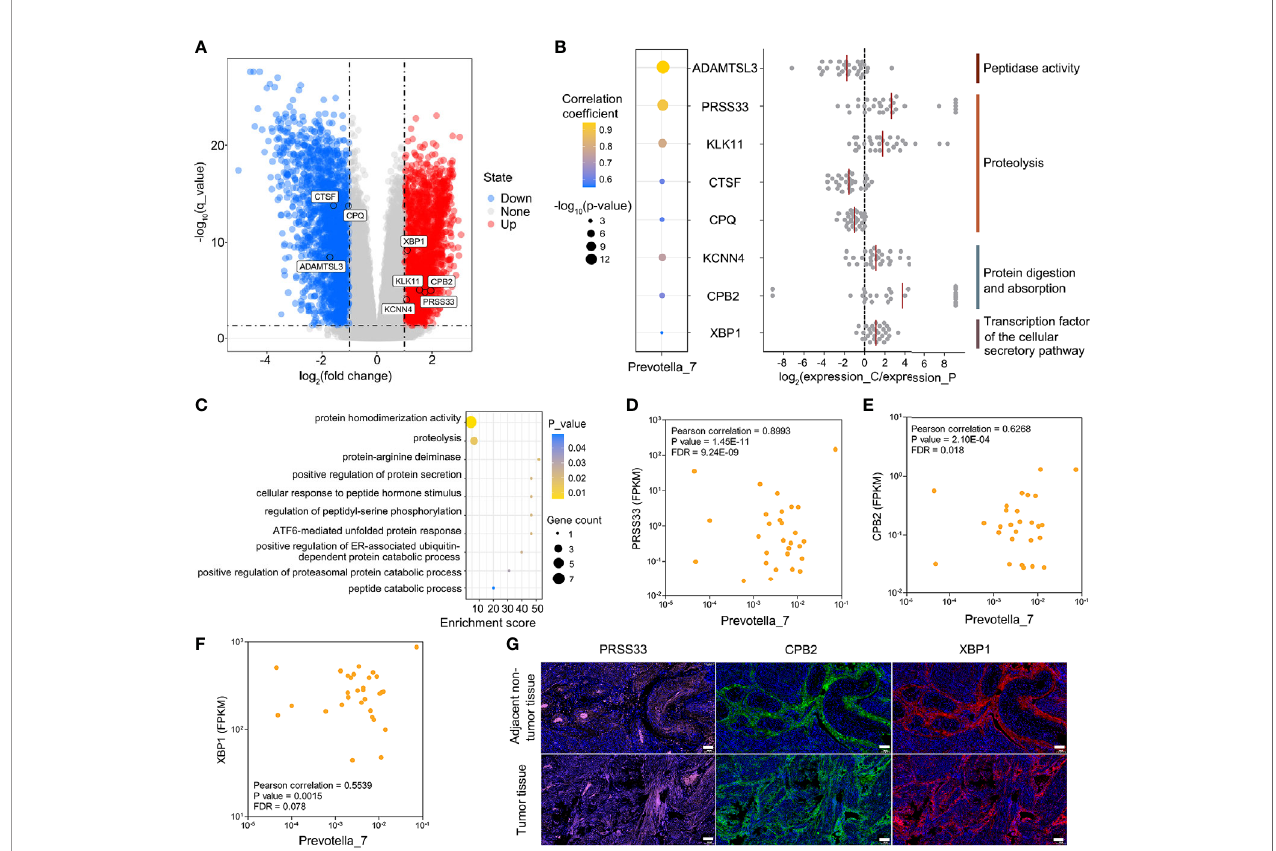
FIGURE 4 | Associations between host endometrial gene expression and Prevotella in patients with EC. (A) Differential expression of Prevotella -associated genes from 30 paired tumor and adjacent nontumor endometrial tissue samples. (B) Integrated analysis of Prevotella -associated genes: microbe-gene correlation dot plot (left panel), log 2 FC value of genes from each patient (middle panel), and functional annotation (right panel). The red line represents the average value. (C) GO enrichment analysis based on the Metascape platform. (D – F) Scatter plots of three typical Prevotella -gene pairs: Prevotella -PRSS33 (D) , Prevotella -CPB2 (E) and Prevotella -XBP1 (F) . Each point represents a patient. (G) Immuno fl uorescence showed the expression levels of PRSS33, CPB2 and XBP1 in endometrial tumor and adjacent non-tumor tissues. The white scale bars are 100 m